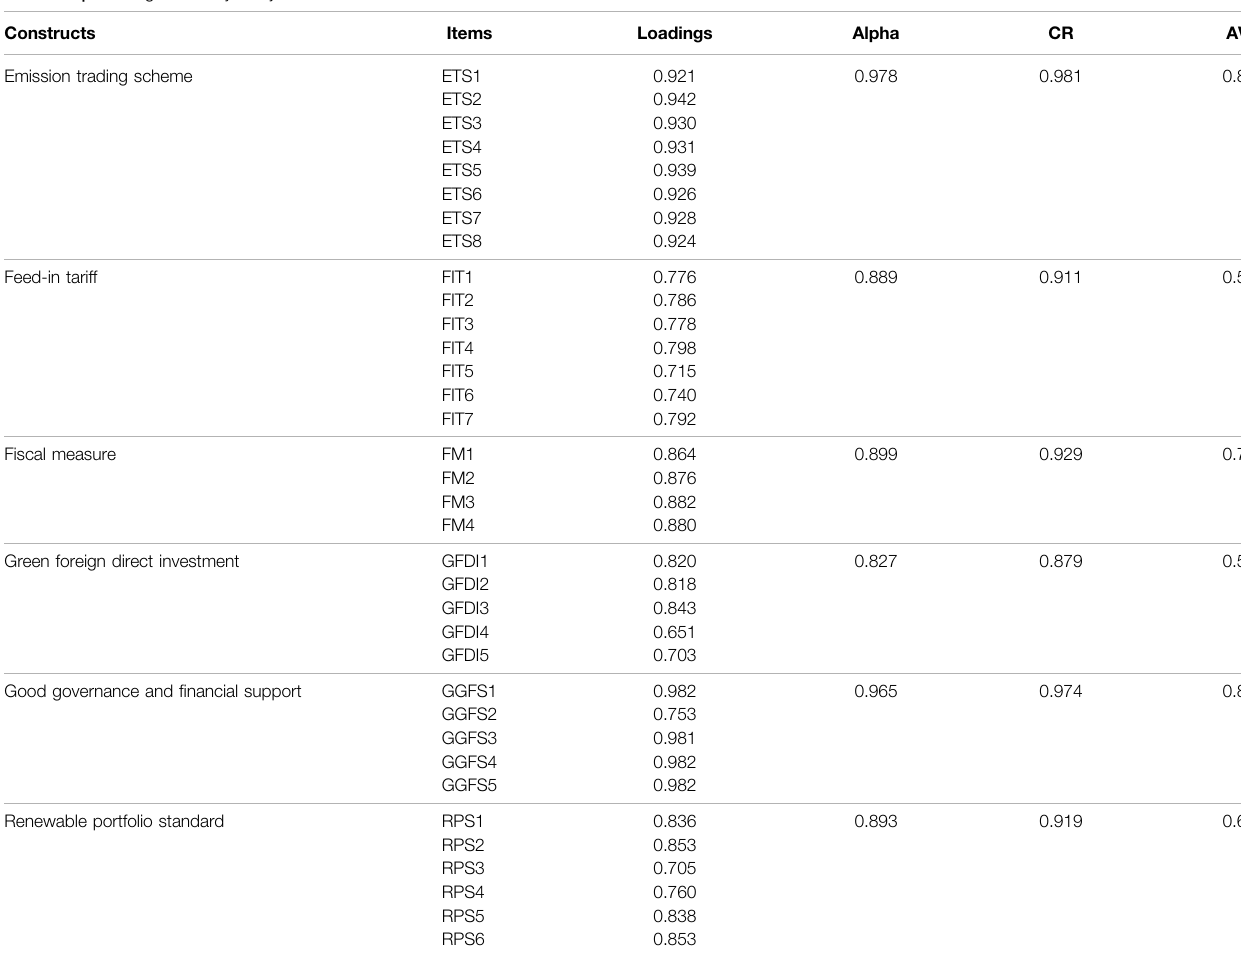
TABLE 2 | Convergent validity